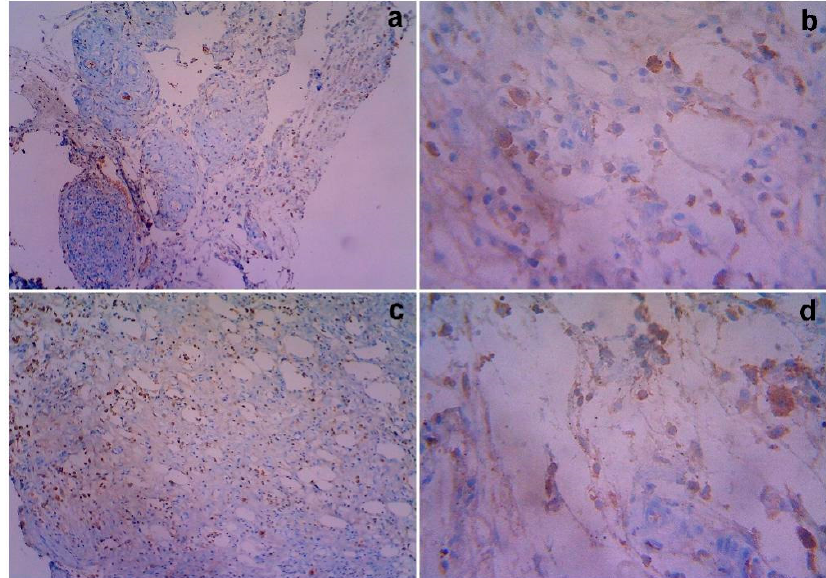
Figure 7. Gross histopathological examination of the different post excisions for iNOS nuclear and cytoplasmic immuno reactive positivity with treated rats on day 14. Representative images of the iNOS nuclear and cytoplasmic section stand for ( a ) 10× showing iNOS for the untreated control cytoplasmic positivity (1+) and immunoreactivity (1+), ( b ). 40× shows granulation tissue shows 1+ respectively. iNOS for MSCs treated group shows Cytoplasmic positivity (2+) and Immunoreactive (2+): ( c ). 10× shows immuno reactive 2+, ( d ). 40× shows immuno reactive 2+, respectively.